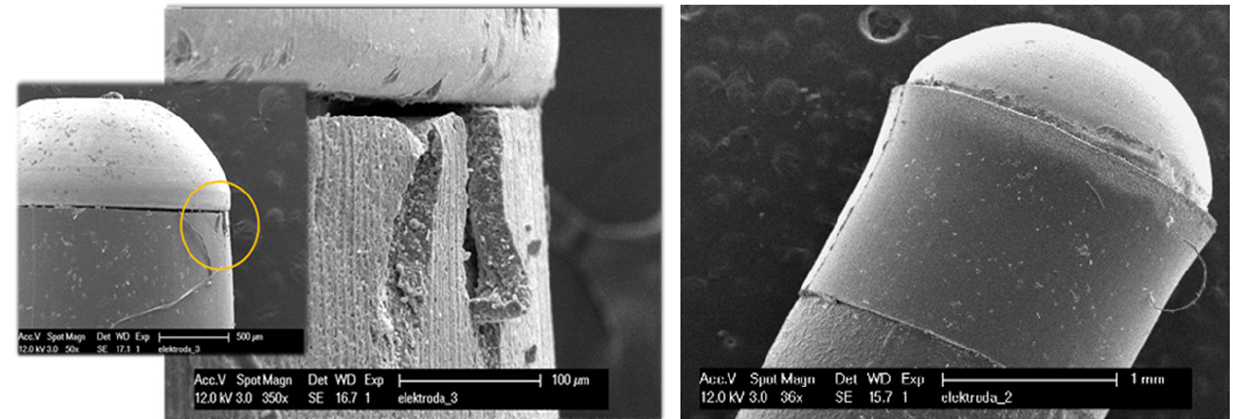
Figure 11: damaged steroid rings on electrodes fixed with stent 3 (left) and stent 4